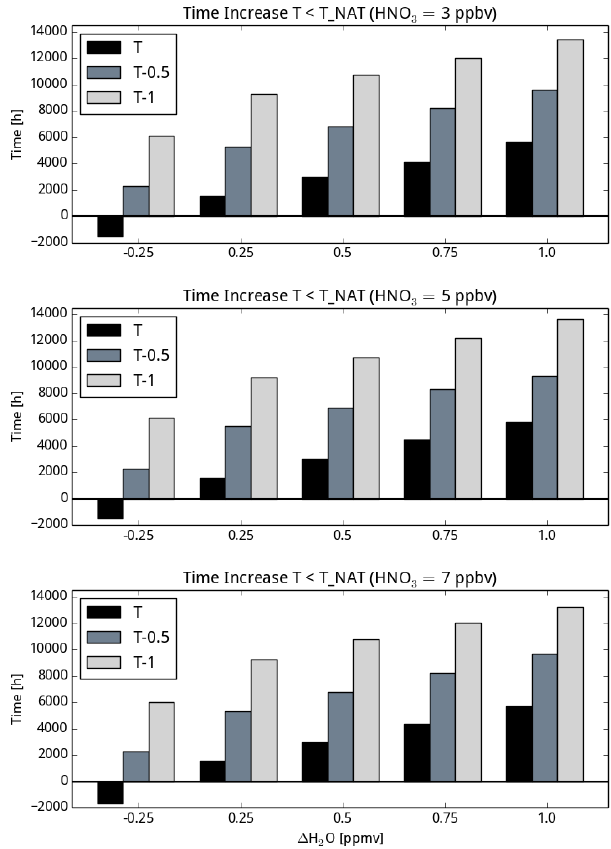
Figure 7. Histograms of the total time where the temperature along the back trajectory is below the NAT existence threshold tempera- ture (sum over all 738 back trajectories) for stratospheric H 2 O mix- ing ratios of 4.75, 5.0, 5.25, 5.5 and 6.0ppmv. The calculation was performed assuming an HNO 3 mixing ratio of 3 (top), 5 (middle) and 7ppbv (bottom).